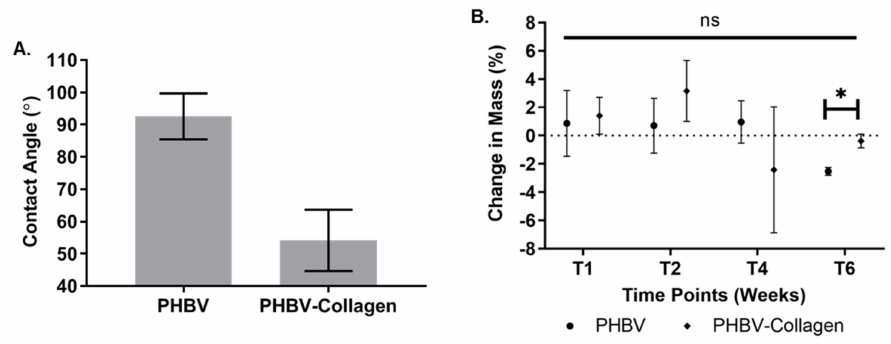
Figure 6. ( A ) Change in PHBV contact angle with collagen conjugation. ( B ) Percentage change in the mass in the conjugated and unconjugated fibres over six weeks of incubation at physiological conditions (* p < 0.05, ns: not significant).